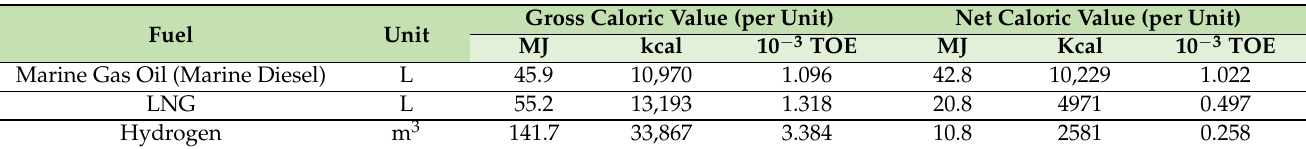
Table 4. Energy content of diesel, LNG, and hydrogen